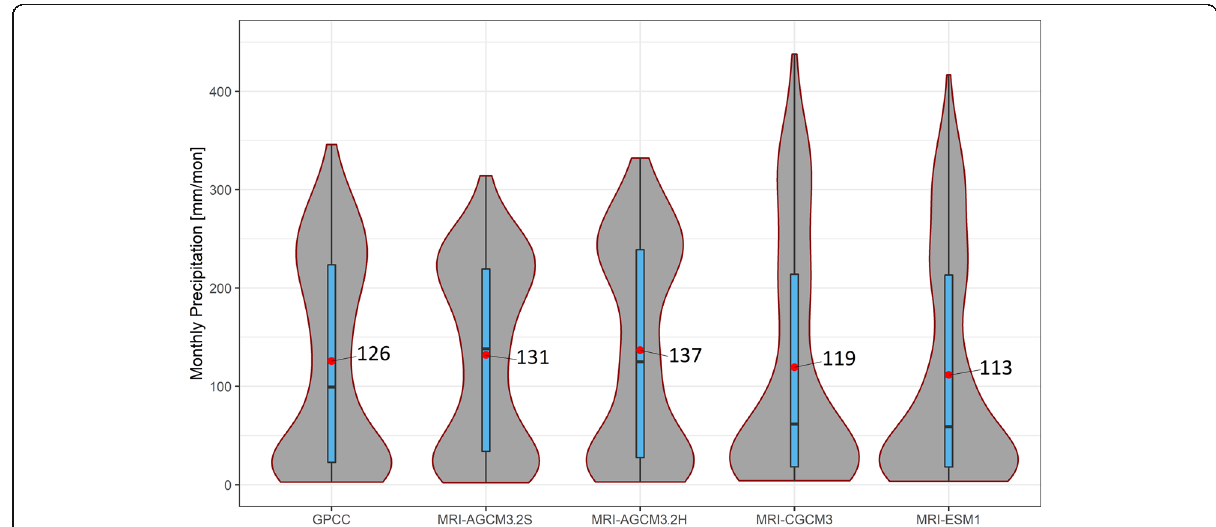
Fig. 14 Violin plot and boxplot of monthly basin precipitation of GPCC and four climate models. The red circle and black dots represent mean and